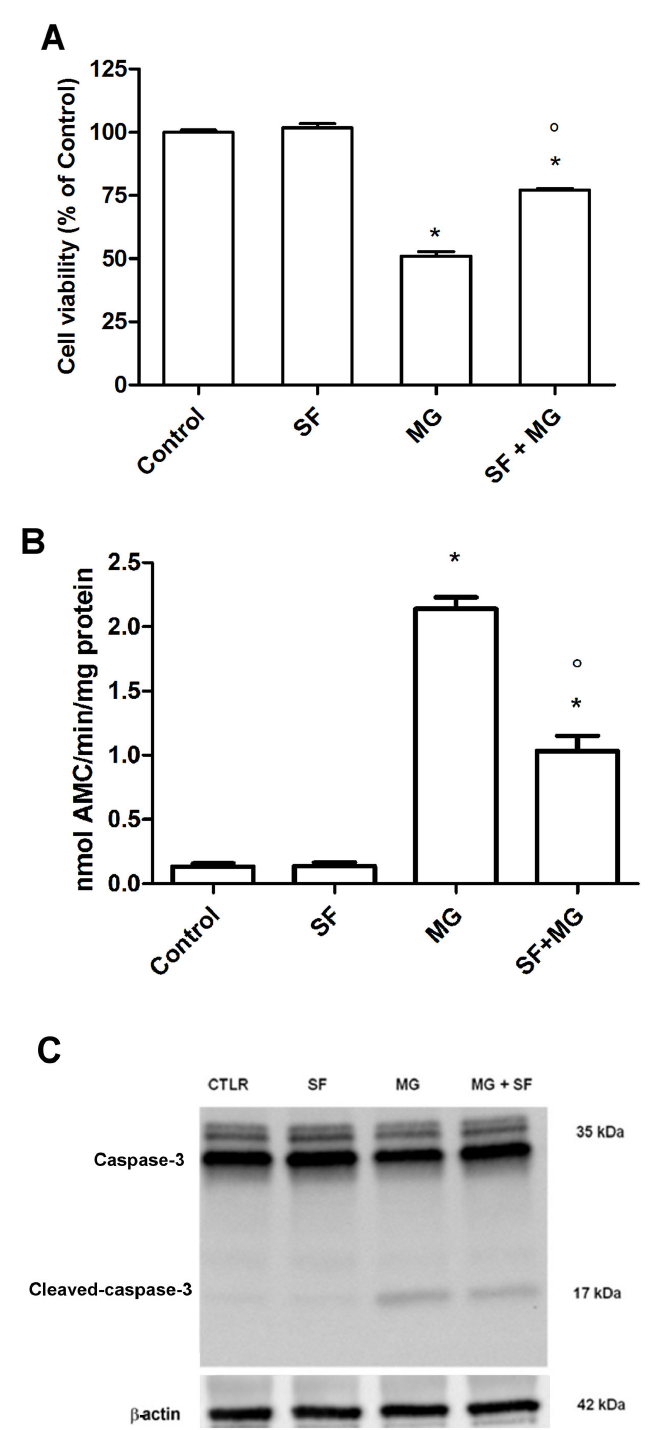
Figure 5. SF protection against MG-induced damage. Cardiomyocytes were treated with 5 µM SF for 24 h before addition of 1 mM MG. ( A ) Cell viability was assessed by MTT assay and reported as percent cell viability in comparison to control. ( B ) Caspase-3 activity was measured spectrofluorimetrically by hydrolysis of the peptide substrate acetyl-Asp-Glu-Val-Asp-7-amido-4- methylcoumarin (Ac-DEVD-AMC). ( C ) Cell lysates were immunoblotted with caspase-3 antibody that detects both full length caspase-3 (35 kDa) and the large fragment of caspase-3 resulting from cleavage (17 kDa). Data are presented as mean ± SD, n = 4 in each group,* p<0.05 vs Control; ° p<0.05 vs MG. doi: 10.1371/journal.pone.0083283.g005 PLOS ONE |